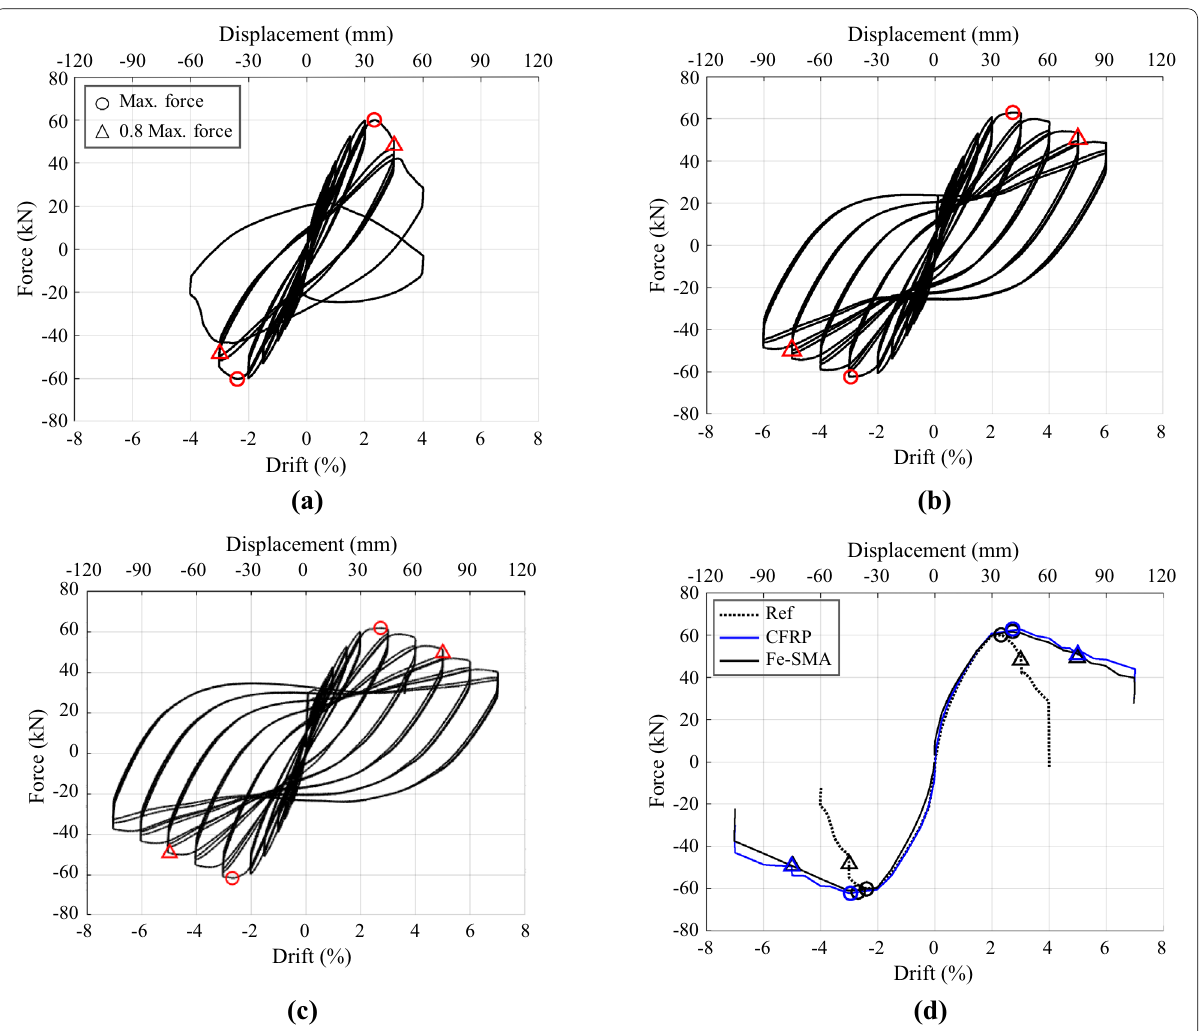
Fig. 10 Lateral force–displacement relationships of the tested columns, where the circle and triangle markers represent the maximum force and 80% of the maximum force, respectively. a Control; b CFRP; c Fe-SMA; d envelop